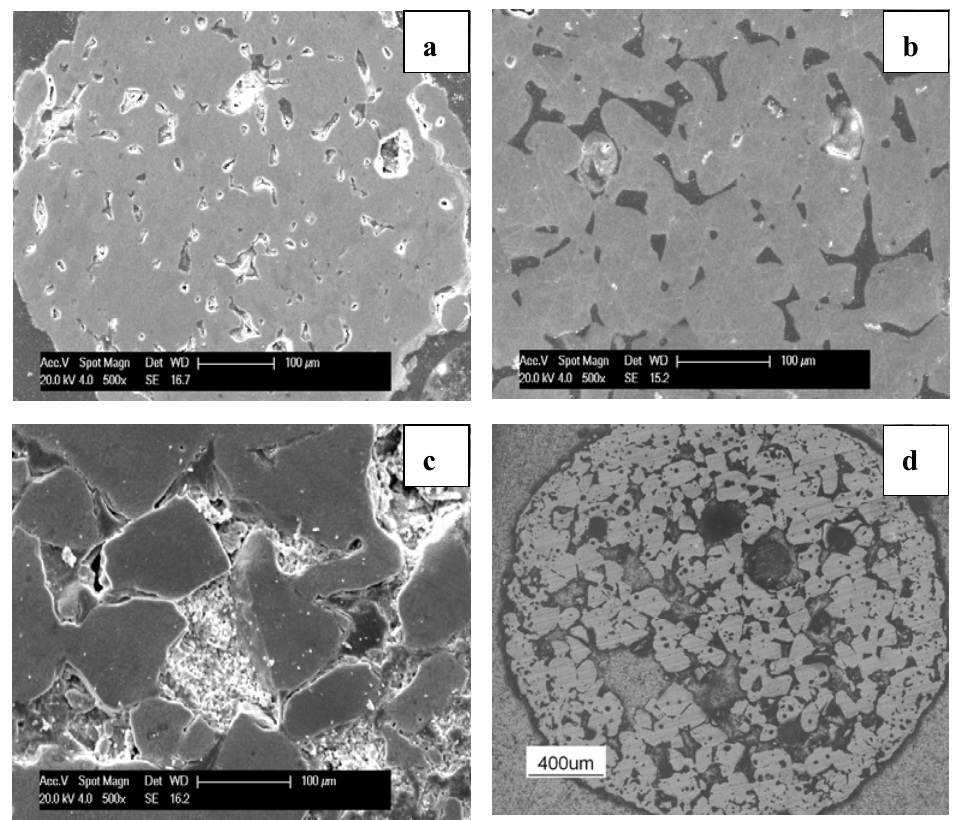
Figure 5. SEM images of cross sections of ( a ) 0.5–1.0 mm; ( b ) 1.4–2.0 mm and ( c ) and ( d ) 2.5–3.1 mm sintered